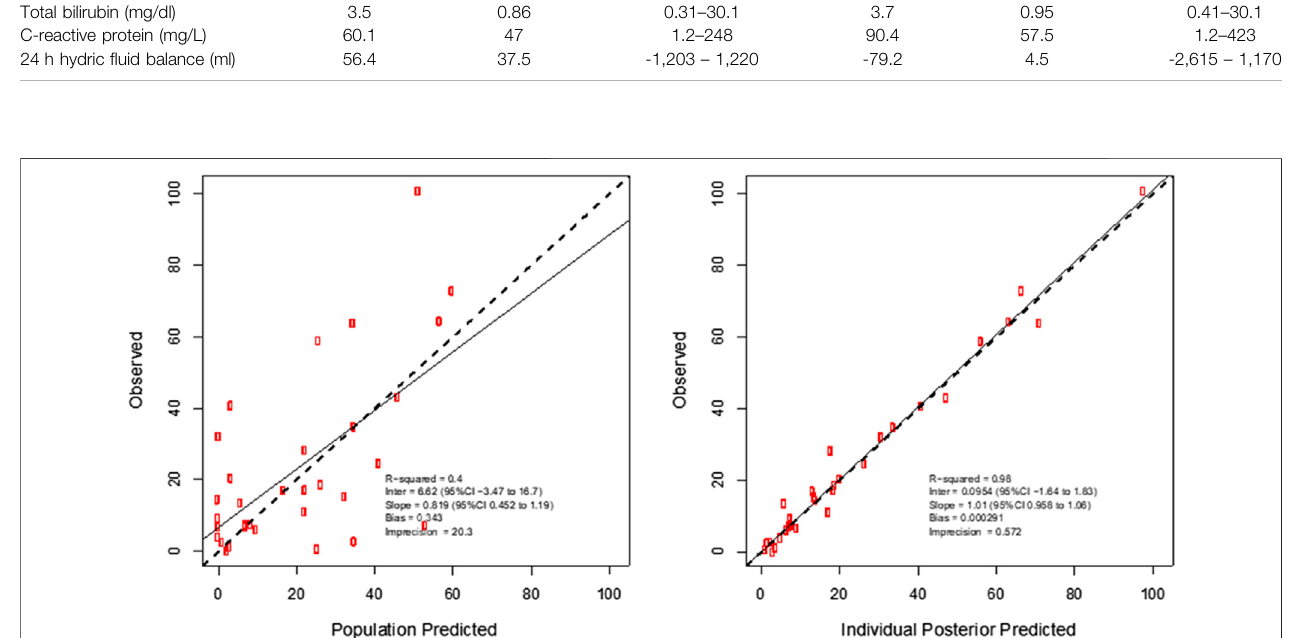
FIGURE 1 | Individual predicted concentration diagnostic plots for the fi nal covariate model for plasma meropenem concentrations. Data are presented in mg/L.